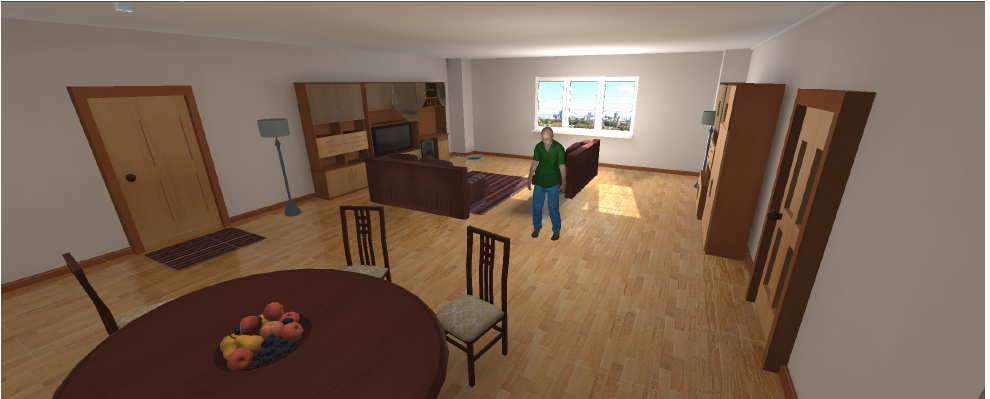
Figure 2. Virtual indoor